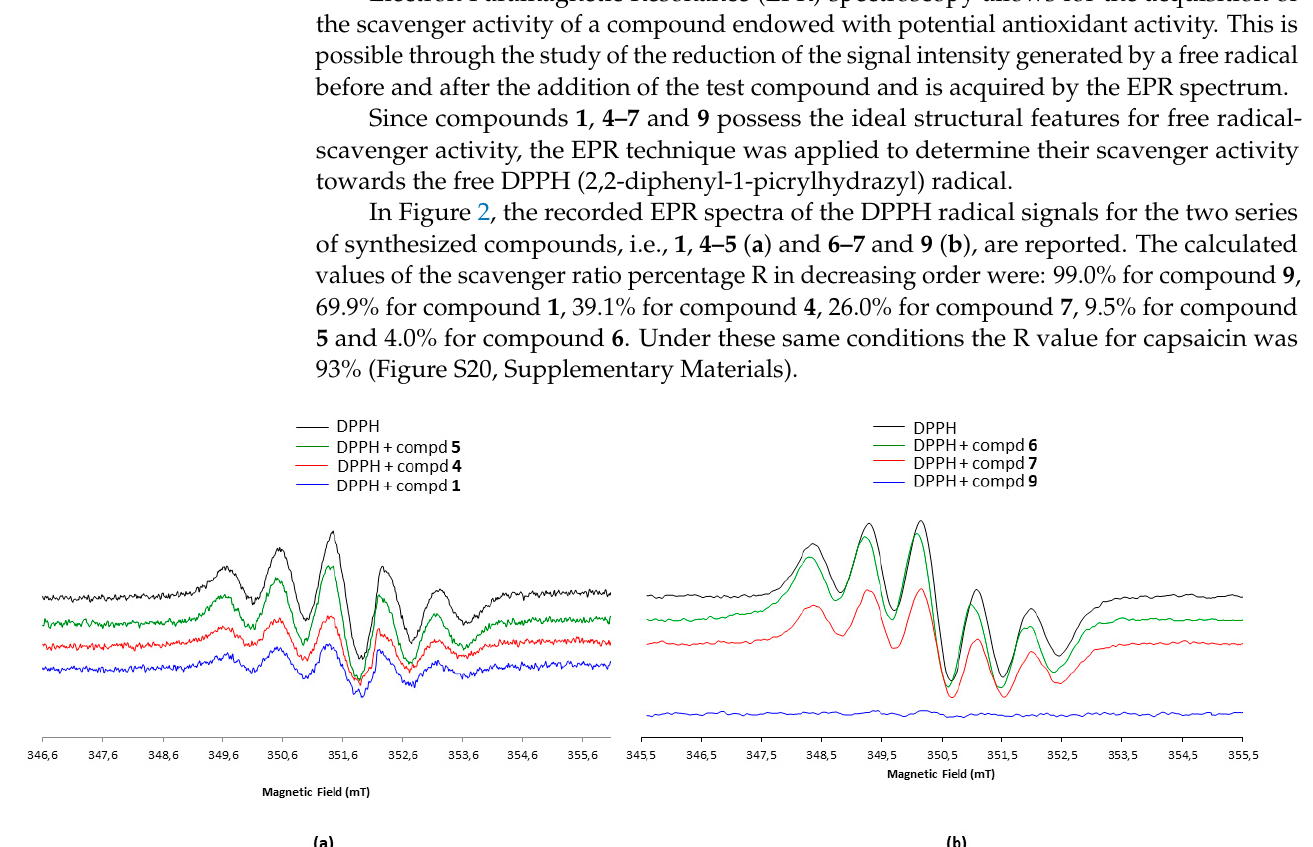
Table 1. Chemical structure and results of TRPV1 functional assay of the lipoic amides 1–9 1 .